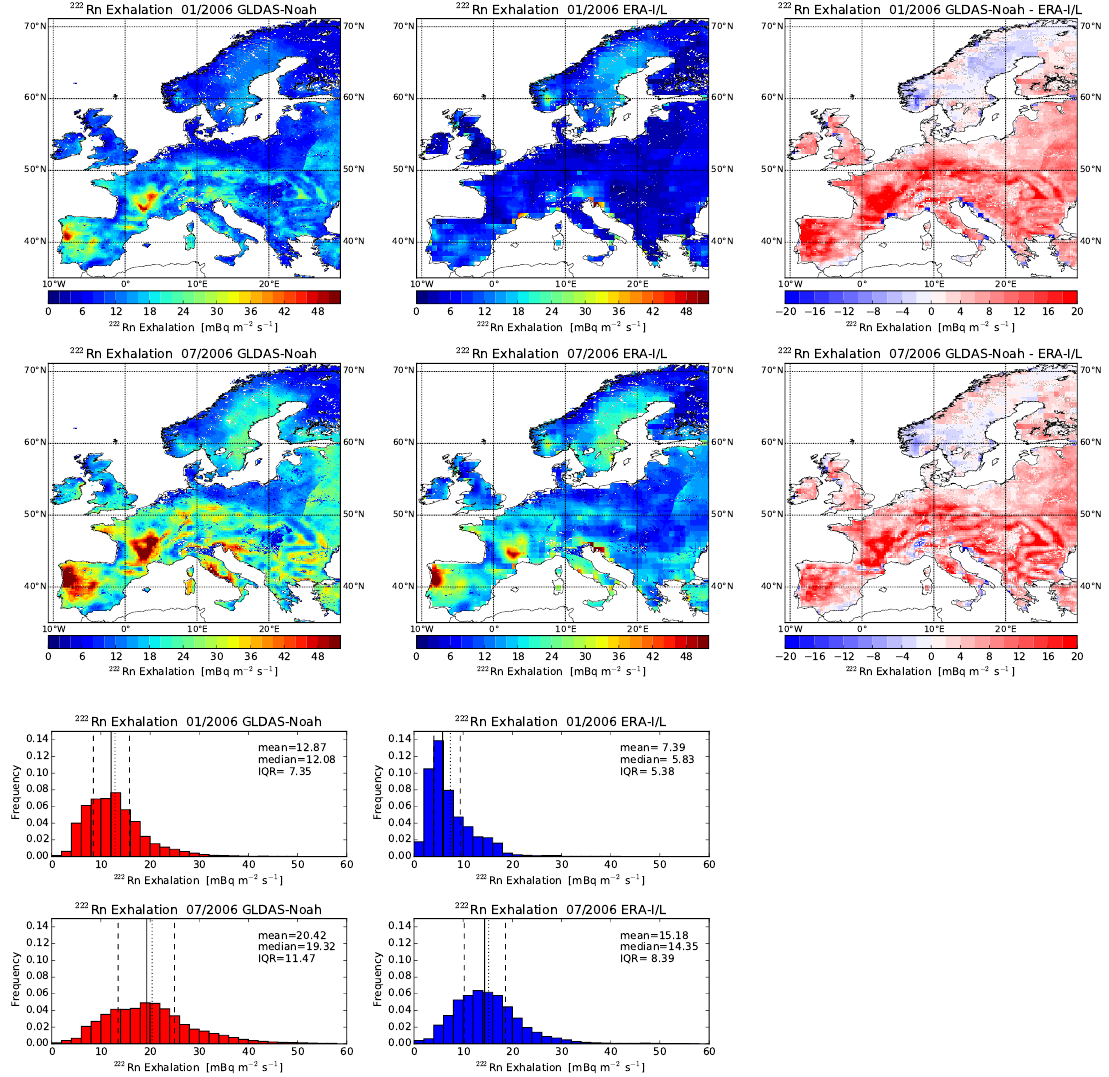
Figure 3. 222 Rn exhalation rate maps of European soils, their differences and frequency distributions for January and July 2006. The left panels show the flux maps and normalized frequency distributions calculated with the monthly mean soil moisture estimates from the GLDAS Noah LSM for January and July 2006, while the middle panels show respective estimates with the ERA-Interim/Land model. The mean values, median values and the interquartile range (IQR) of the normalized frequency distributions of January and July 2006 fluxes (in mBqm − 2 s − 1 ) are also given. The right panels show the differences between GLDAS-Noah- and ERA-Interim/Land-based